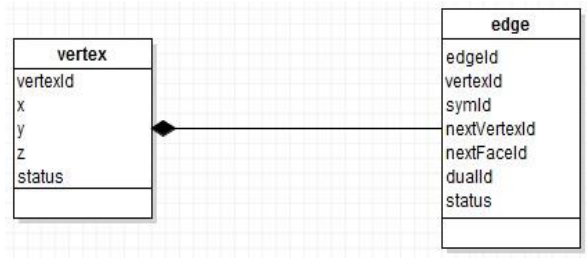
Figure 10 . Tables representing two main primitives.